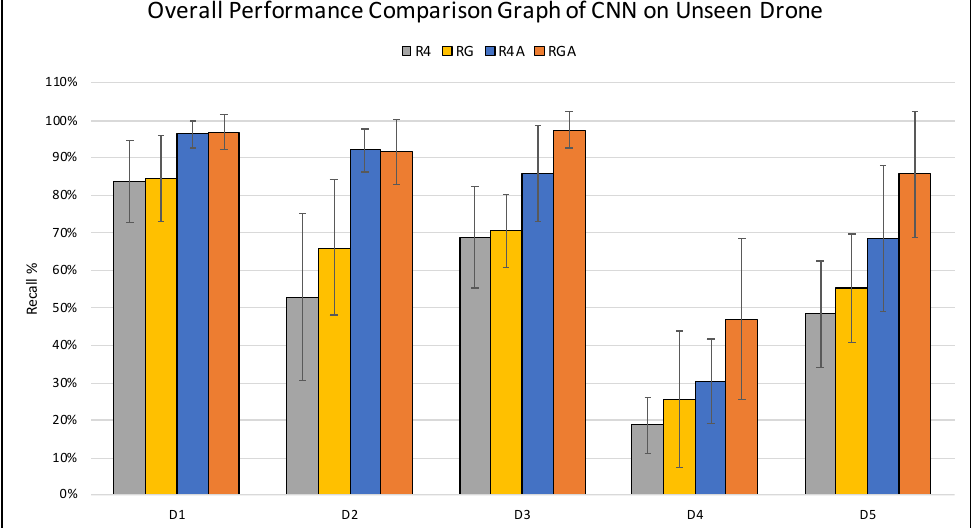
Figure 12. The performance of the average CNN models trained on all proposed drone datasets and tested on unseen drones of in terms of recall